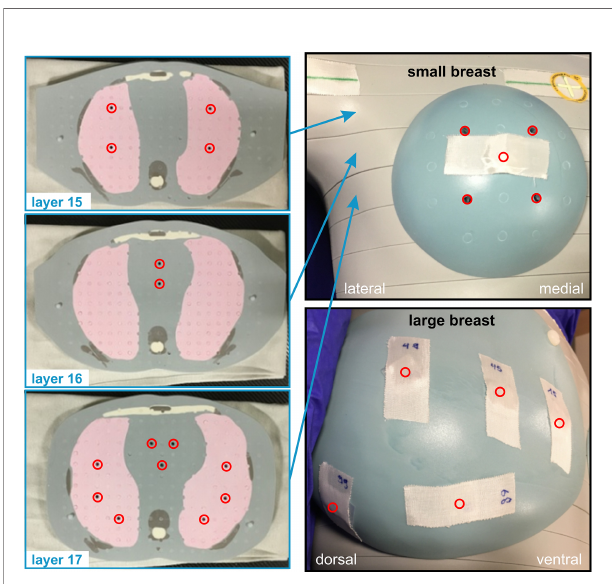
FIGURE 3 | TLD placement inside and on the surface of the anthropomorphic phantom. In the superior – inferior direction, different phantom layers with numbers 15 to 17 are shown on the left side of the image. The TLD positions are depicted as red circles. On the right side, the placement regarding the small and large breast add-ons is